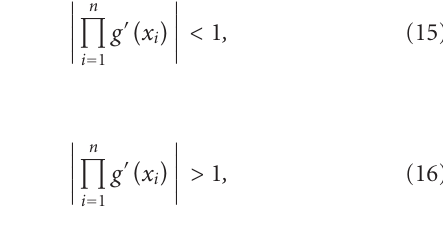
episode converges to an infinite number of period doublings at which point chaos is observed. This is depicted in the bi- furcation diagram in Figure